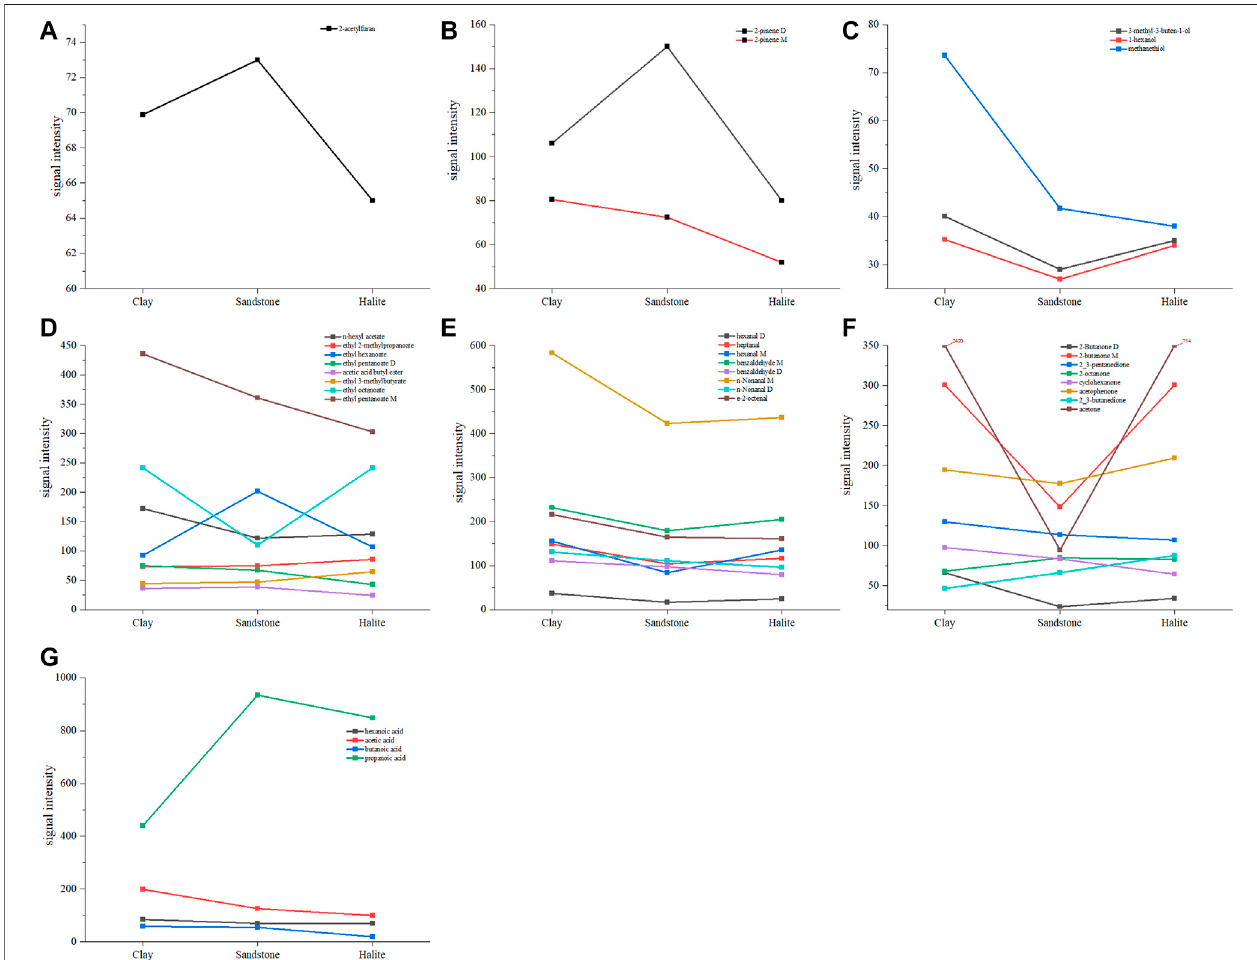
FIGURE 5 | Line graph showing the mean intensity of identi fi ed compounds in the samples. Note: (A) One furan; (B) Two terpenes; (C) Three alcohols; (D) Eight esters; (E) Eight phenols; (F) Eight ketones; and (G) Four acids.